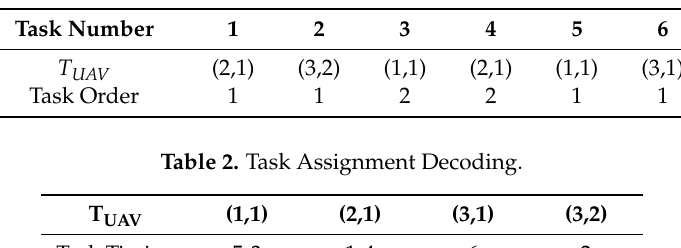
Table 1. Example of UAV Task Assignment.